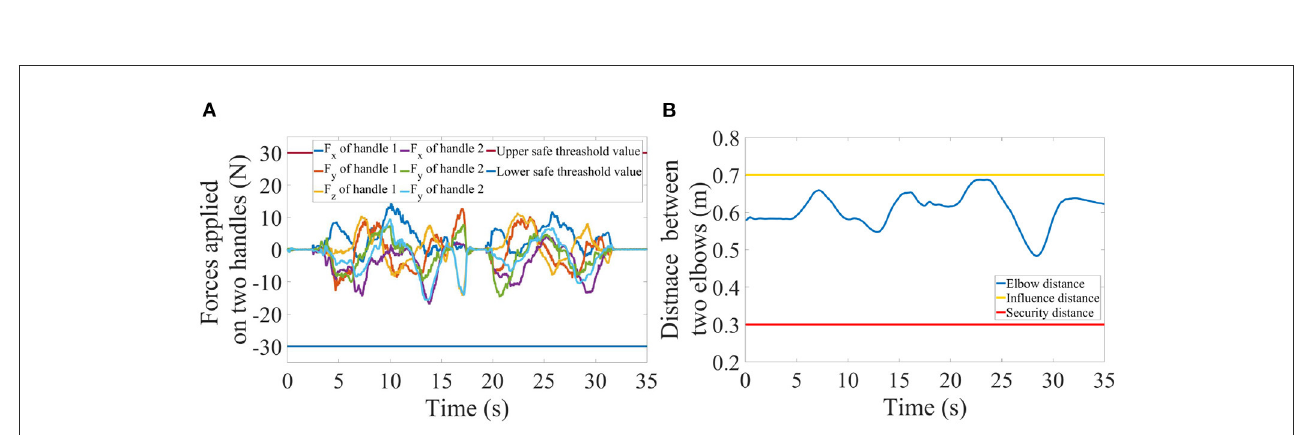
FIGURE8 Profiles of the forces applied on the two handles (A) and the distance trajectory between the two elbows (B) in scenario